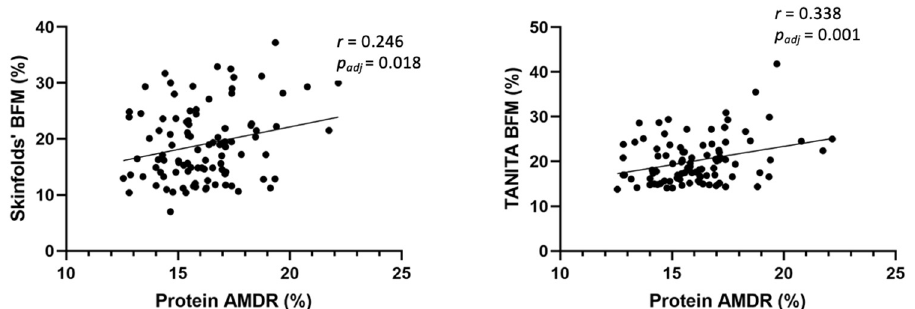
Figure 5. Partial correlation to evaluate potential associations between BFM and dietary in- take in children at 6 years, adjusted by study group, maternal age, parents’ educational level, and socioeconomic status. AMDR: acceptable macronutrient distribution ranges; BFM: body fat mass; TANITA ® : bioelectrical impedance.